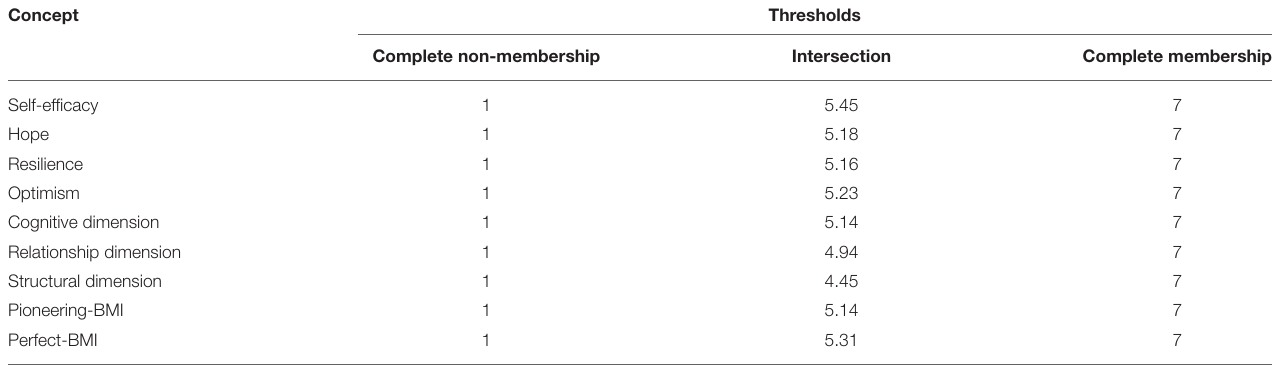
TABLE 2 | Assignment criteria ( n = 242).